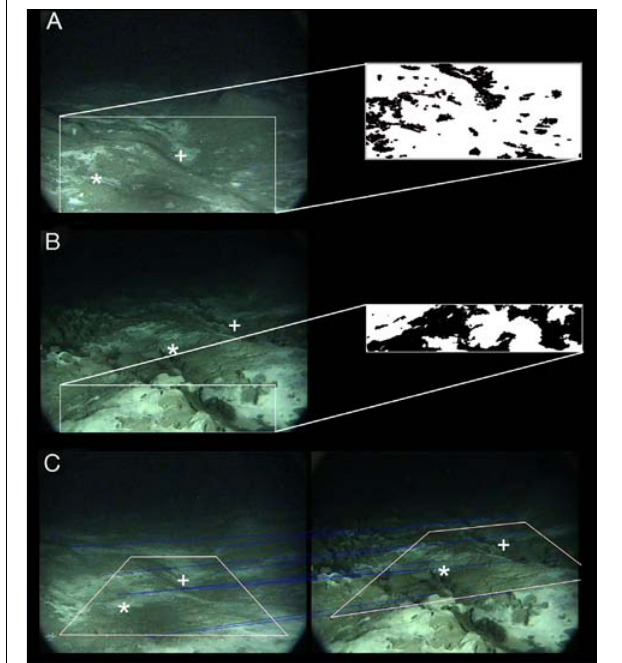
FIGURE 3 | Methods employed to estimate the cover of microbial mats before and after the mud eruption. (A) Area (0.6 m 2 ) analyzed for changes in microbial mat cover before the eruption. (B) Area (0.12 m 2 ) analyzed for changes in microbial mat cover after the eruption. (C) Area selected to compare microbial mat cover immediately before and after the eruption. Microbial mats were digitized in Photoshop R (cid:13) (A,B) and percent covers were computed in IP Lab Spectrum. Common features between images are indicated (* or